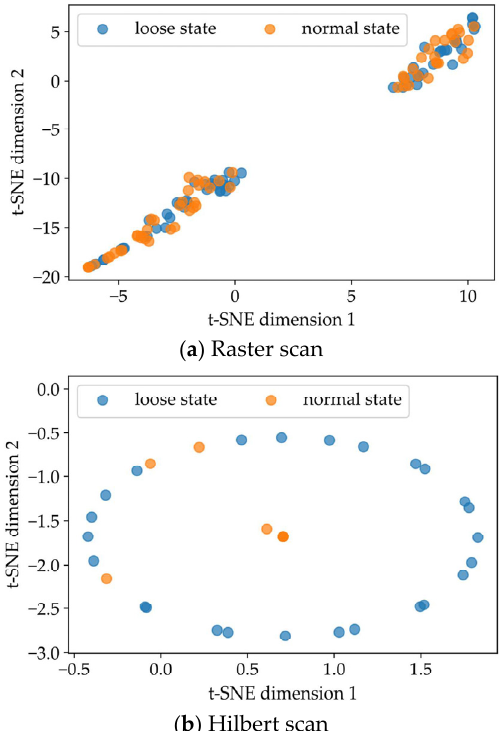
Figure 11. Clustering visualization results of fastener state feature of ( a ) Raster scan and ( b ) Hilbert scan based on t-SNE.